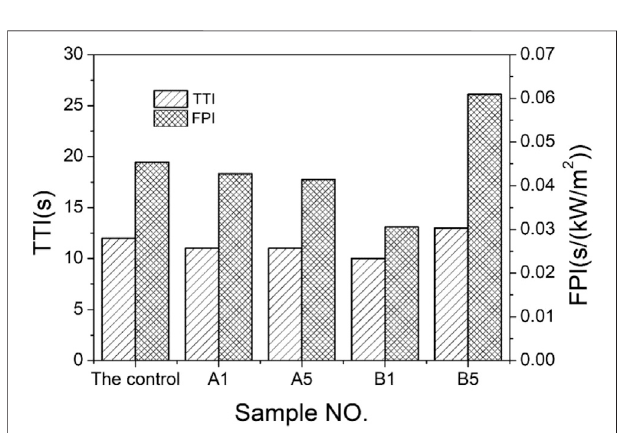
FIGURE6| TTIandFPIofbamboospecimensbeforeandafterLbLself- assembly with